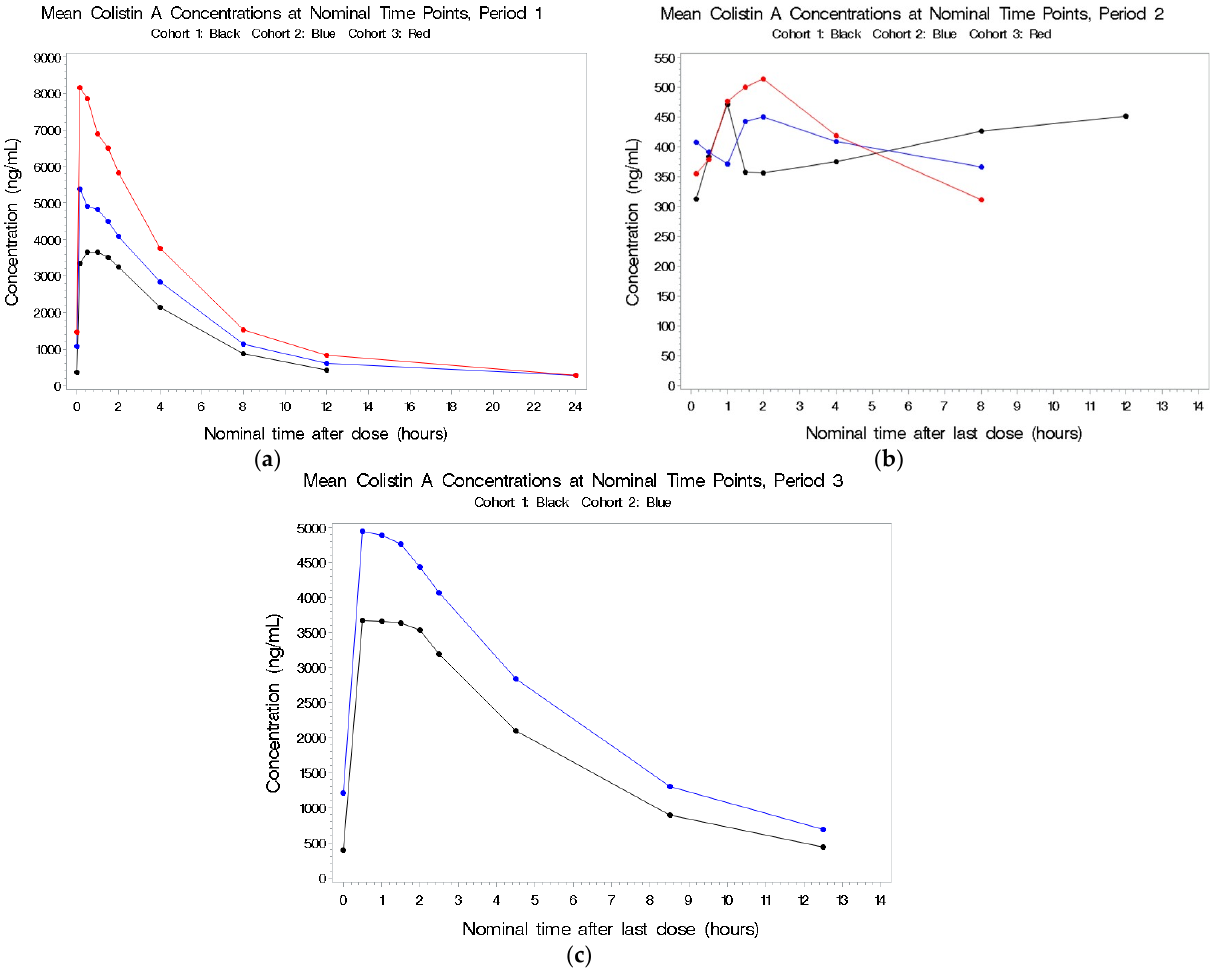
Figure 1. ( a – c ) Mean plasma concentrations for colistin A after last dose in Period 1 by cohort.